Question: Identify the chart type used in this figure.
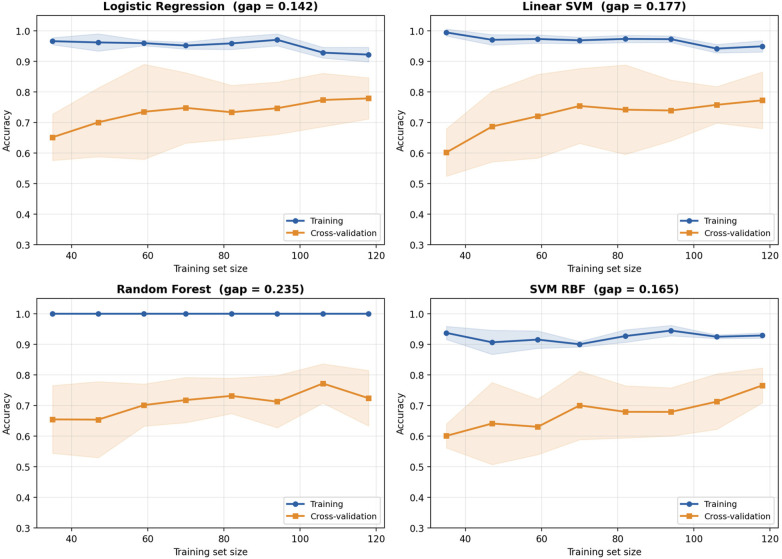
Answer: line